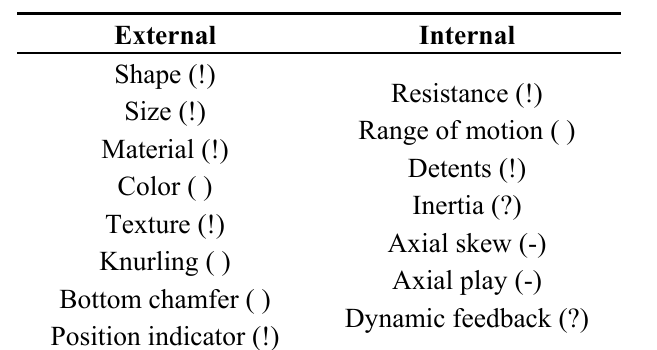
Figure 5. External knob characteristics study. Table 1. Knob parameters and their relation to musical interaction: important ( ! ), neutral ( ), eliminate (-), and unknown ( ?